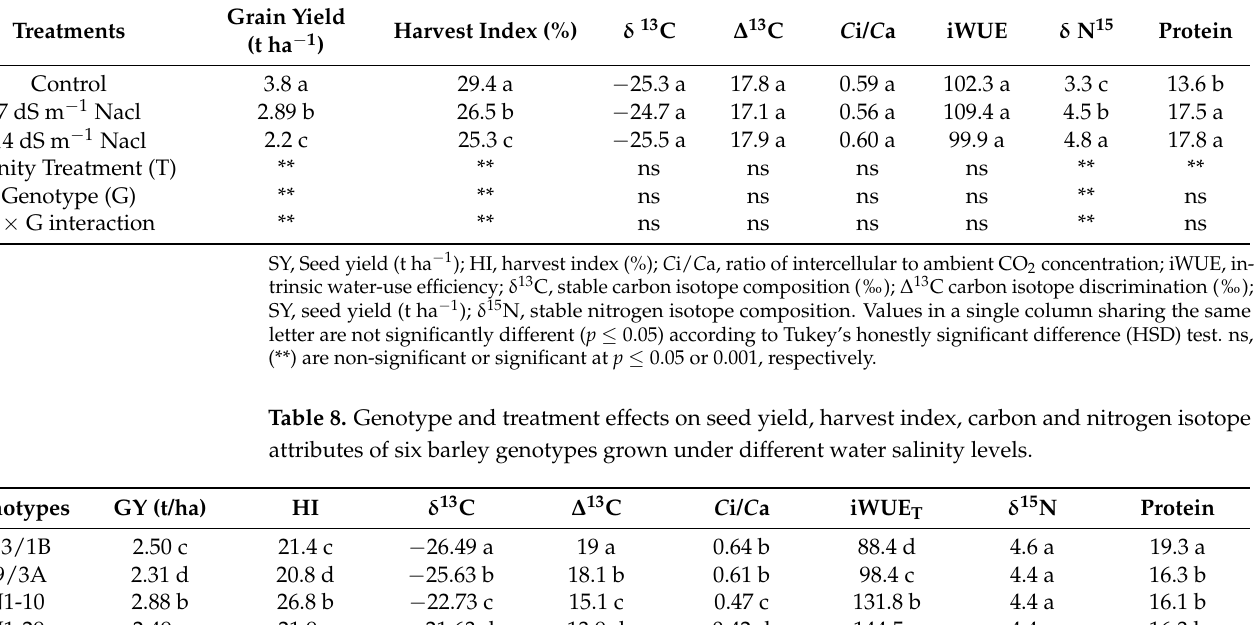
Table 7. Genotype and treatment effects on seed yield, harvest index, carbon and nitrogen isotope attributes of six barley genotypes grown under different water salinity levels.